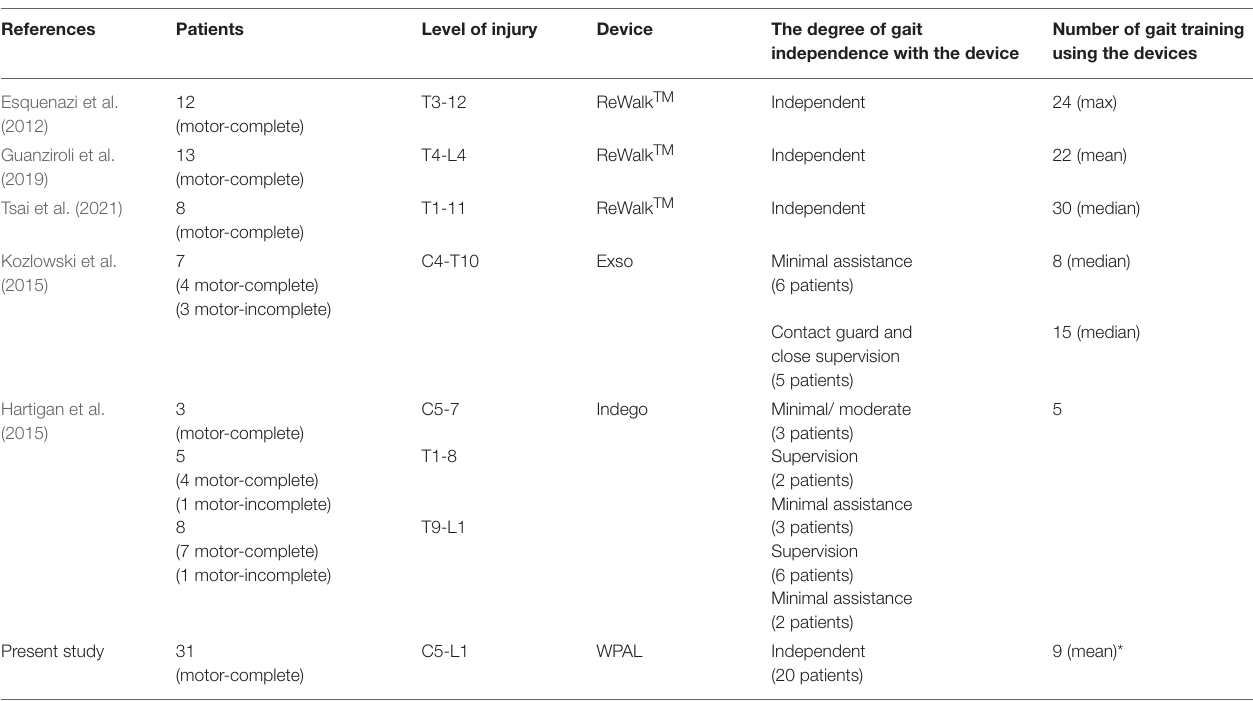
TABLE 4 | Summary results of previous studies and the present